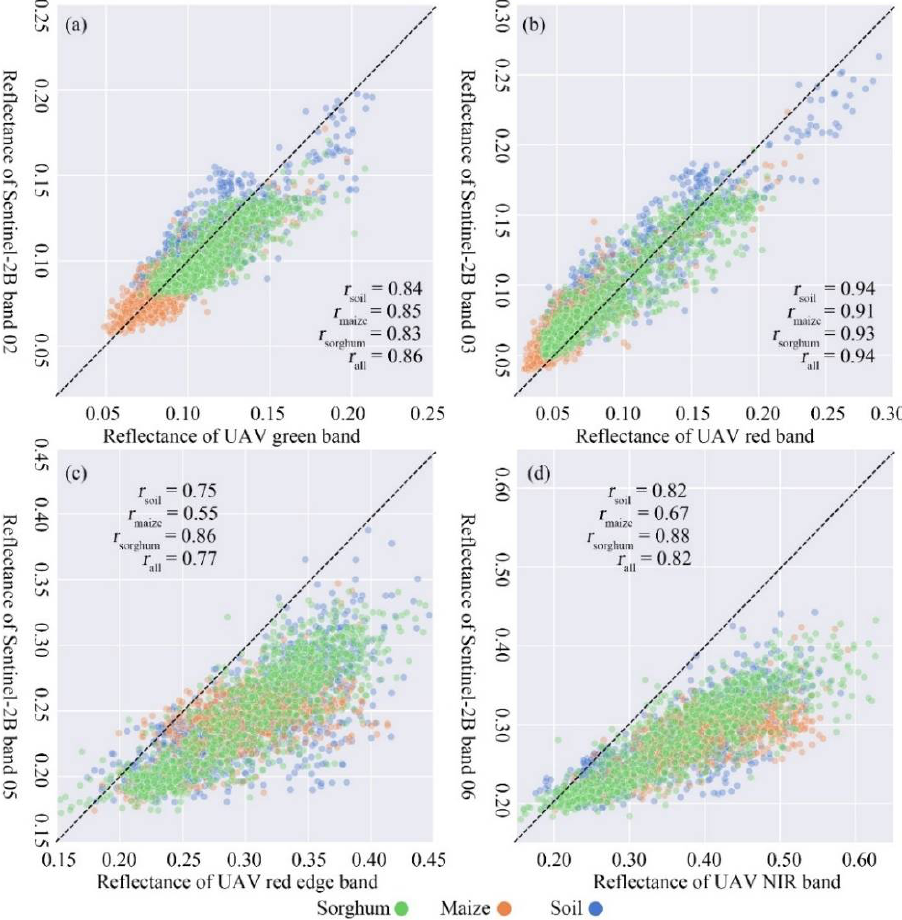
Figure 6. Relationships between the reflectance of UAV and Sentinel-2B bands: ( a ) green, UAV 530–570 nm versus Sentinel-2B 536–582 nm (band 02); ( b ) red, UAV 640–680 nm versus Sentinel-2B 645–685 nm (band 03); ( c ) red edge, UAV 730–740 nm versus Sentinel-2B 730–748 nm (band 05); and ( d ) NIR, UAV 770–810 nm versus Sentinel-2B 766–794 nm (band 06).